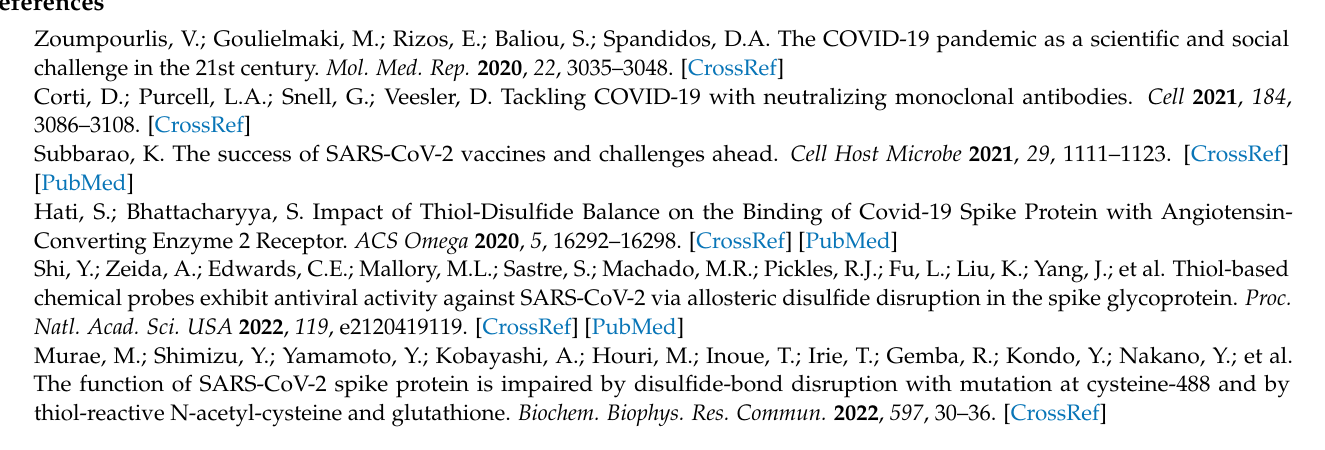
lized in Figure 3. Figure S2: Cytotoxicity of selected natural compounds. Figure S3: Binding